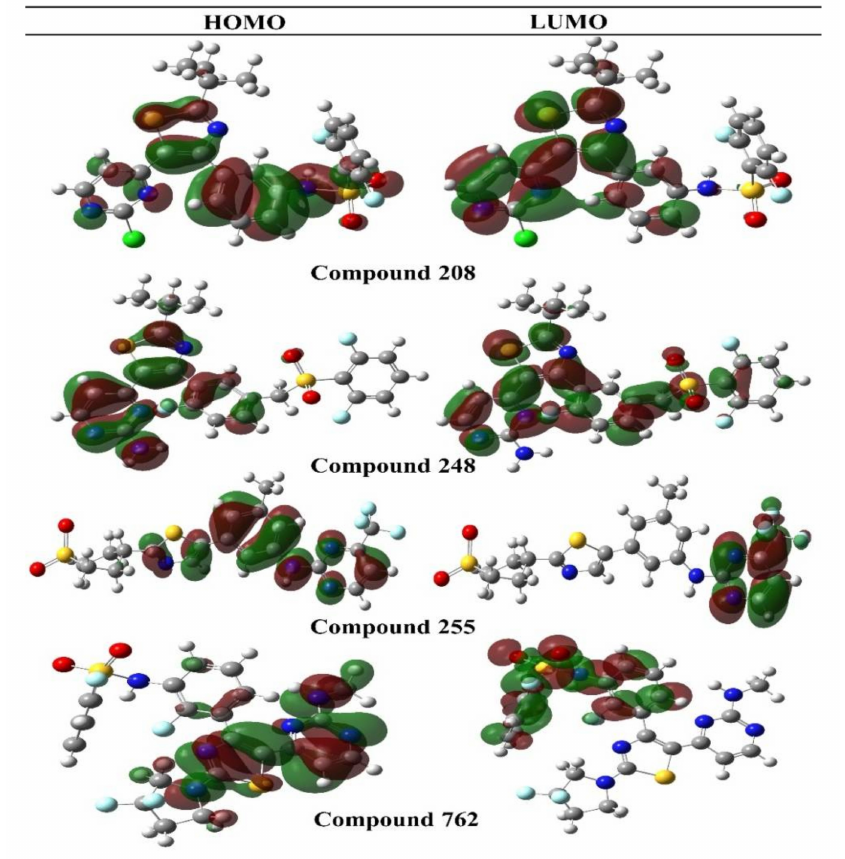
Figure 4. HOMO–LUMO structures of the selected